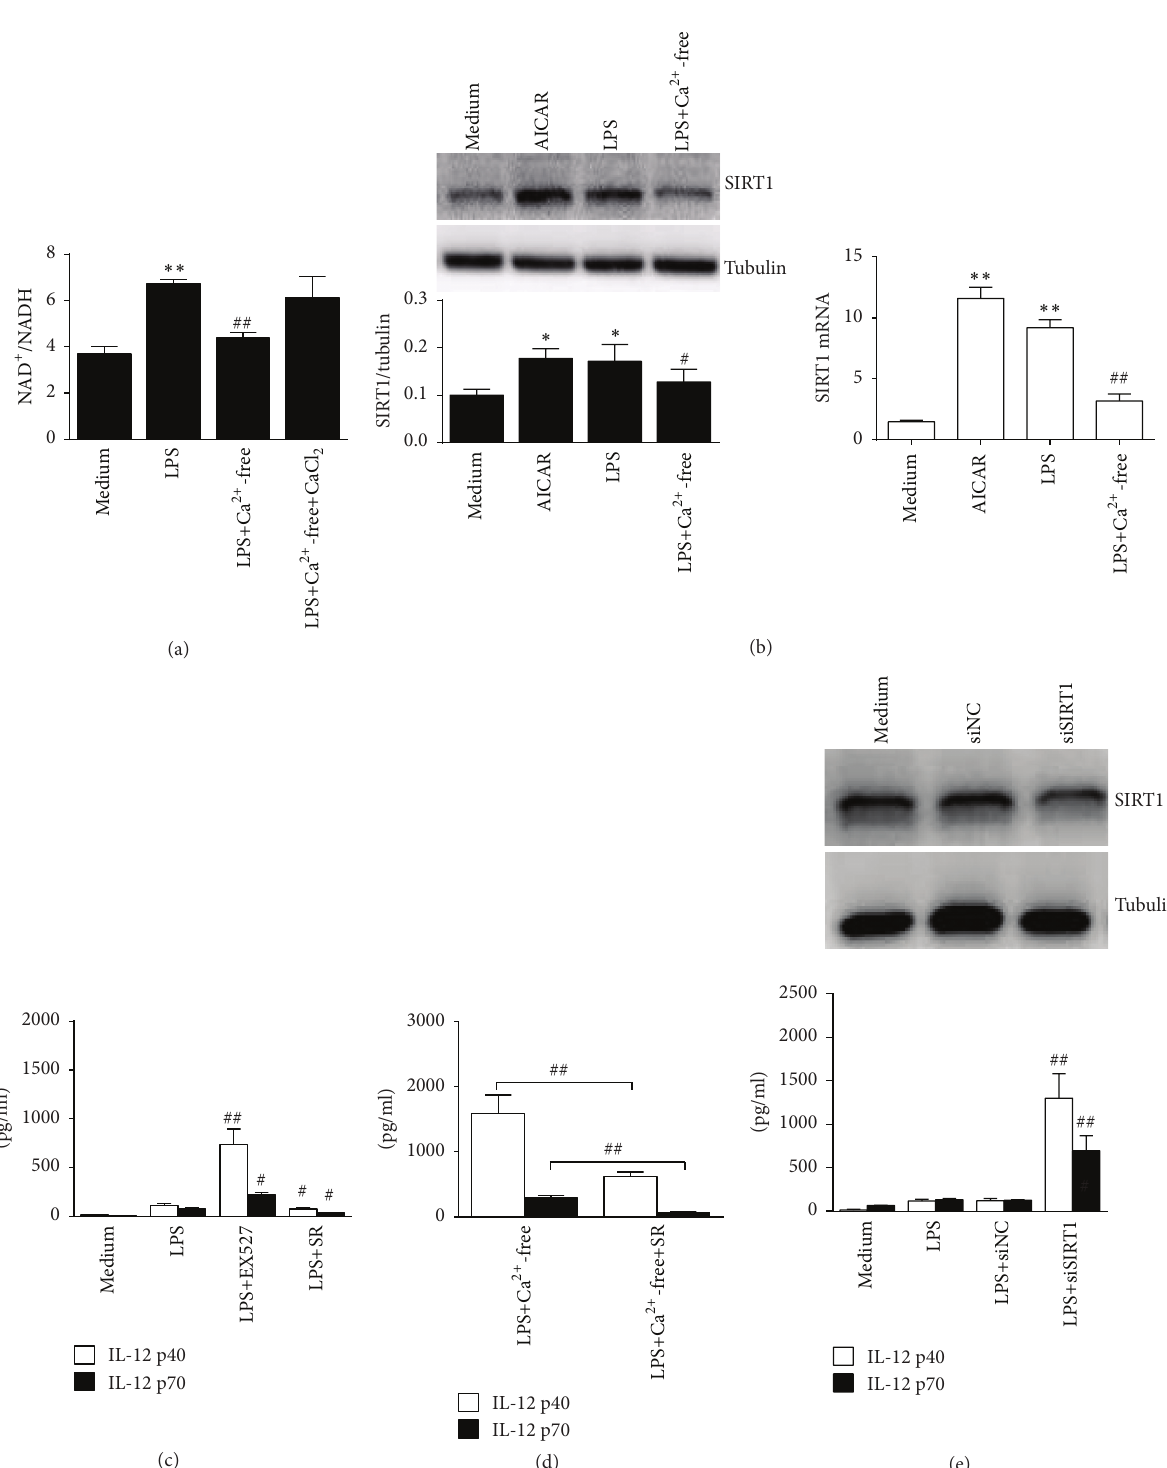
Figure 6: SIRT1 is upregulated by AMPK activation to suppress IL-12 expression in the LPS-activated RAW 264.7 cells. (a) Cells were treated with 100ng/mL LPS in normal DMEM or in DMEM without calcium or supplemented with 2mM CaCl 2 for 1h. NAD + /NADH levels were detected ( 𝑛 = 3 ). (b) Cells were treated with 1mM AICAR, 100 ng/mL LPS, or LPS plus calcium-free DMEM for 2 h. Protein and mRNA levels of SIRT1 were detected by western blot or real-time PCR. ∗ 𝑃 < 0.05 and ∗∗ 𝑃 < 0.01 versus medium; # 𝑃 < 0.05 or ## 𝑃 < 0.01 versus LPS ( 𝑛 = 3 ). (c, d) Cells were treated with LPS alone or with 2 𝜇 M EXT527 or 2 𝜇 M SRT1720 (c). Cells were also treated with LPS, calcium-free LPS, or calcium-free LPS with SRT1720 (d). Supernatants IL-12 p40 and IL-12 p70 (24 h) were detected by ELISA. # 𝑃 < 0.05 and ## 𝑃 < 0.01 versus LPS for each cytokine ( 𝑛 = 3 ). (e) Cells were treated with NC siRNA or SIRT1 siRNA for 24 h. Protein levels of SIRT1 were detected by western blot (upper). The siRNA-treated cells were further stimulated by 100ng/mL LPS for 24 h (lower). Supernatants IL-12 p40 and IL-12 p70 were detected. # 𝑃 < 0.05 and ## 𝑃 < 0.01 versus LPS for each cytokine ( 𝑛 = 3